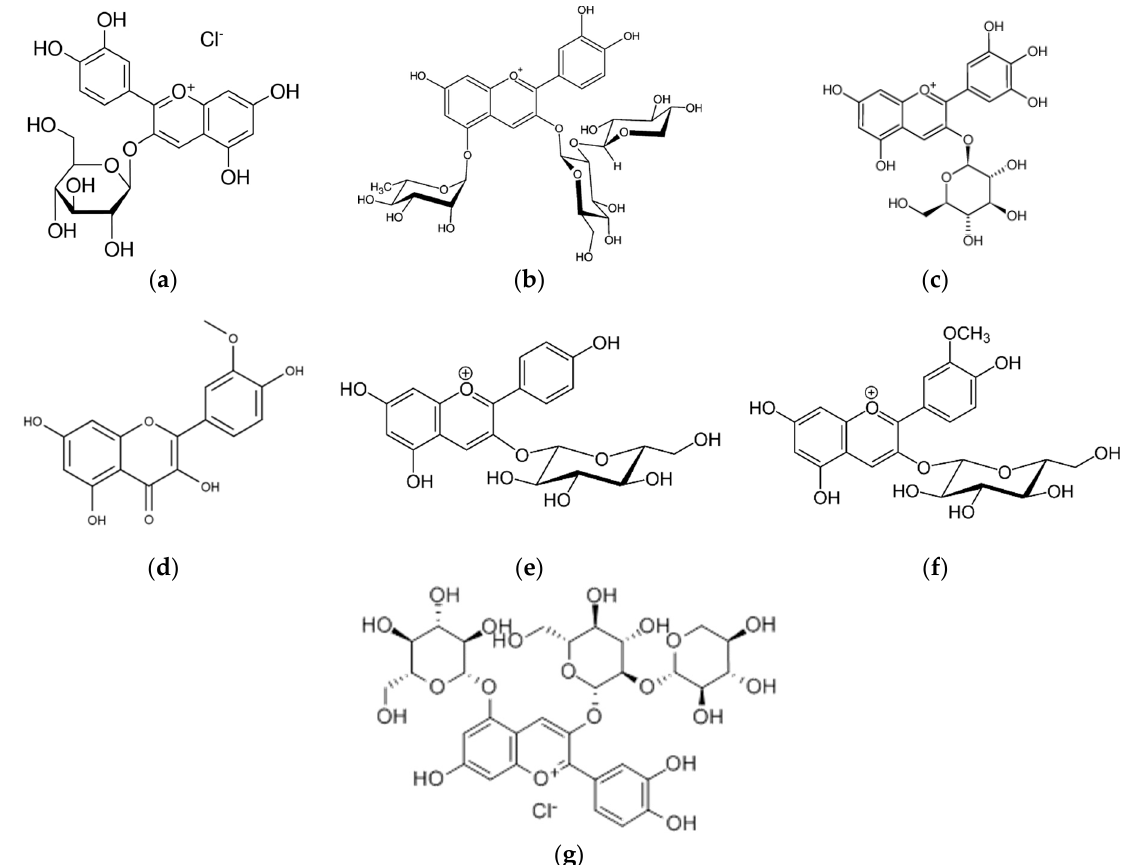
Figure 3. Chemical structures of the anthocyanins compounds: ( a ) cyanidin-3-glucoside, ( b ) cyanidin-3-rutinoside, ( c ) delphinidin-3-O-glucoside, ( d ) peonidin-3-O-rutinoIe, ( e ) pelargonidin-3-O-glucoside, ( f ) peonidin-3-O-glucoside, ( g ) cyanidin-3-sophorose-5-glucoside.